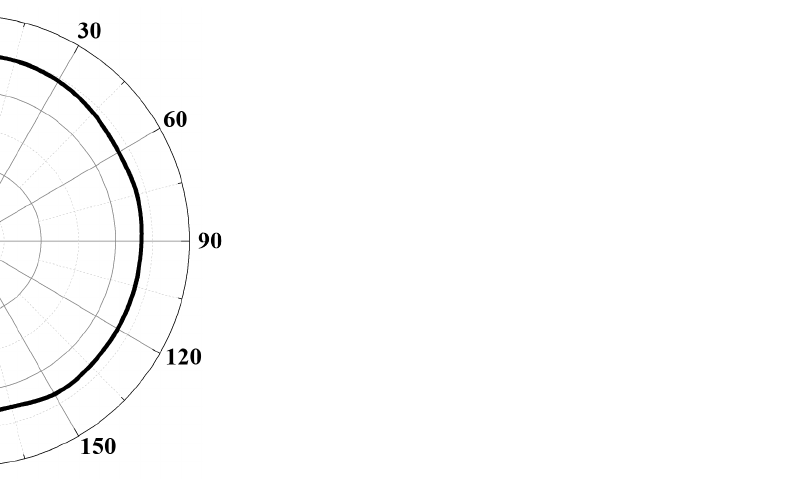
Figure 10. Relative temperature distribution over the horizontal pipe surface. Comparing Figures 9 and 10 confirms the gradient heatmetry informativeness. The temperature measurement does not allow us to determine the condensate accumulation region. At the same time, the gradient heatmetry results allow us to propose ways to enhance heat transfer. For example, it is possible to use specially shaped fins only in the sub-bottom area. Simultaneous measurement of heat flux and temperature made it possible to determine the HTC distribution over the horizontal pipe surface. Figure 11 shows relative HTC distribution for a horizontal pipe obtained experimentally.